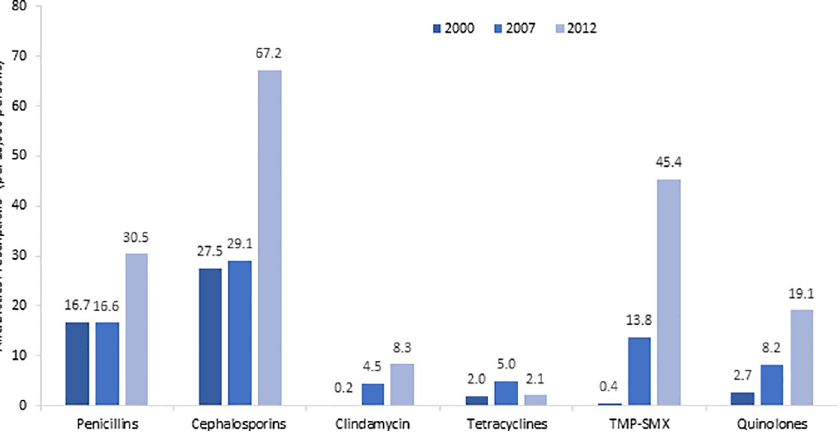
Fig 3. Most frequently prescribed antibiotics for SSTIs, 2000, 2007 and 2012. TMP-SMX = sulfamethoxazole-